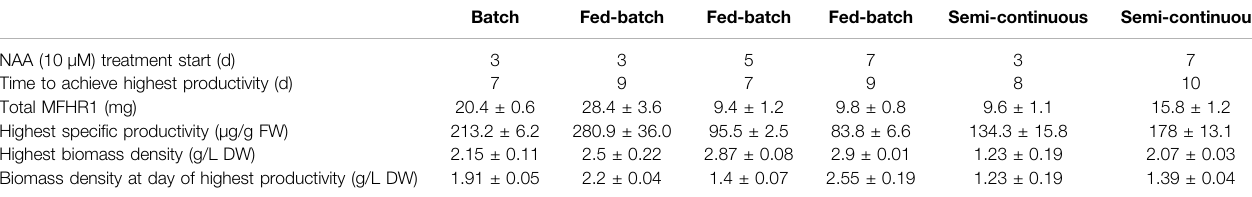
TABLE 3 | Biomass and recombinant protein (MFHR1) production of line B under different operation conditions with exogenous auxin NAA (10